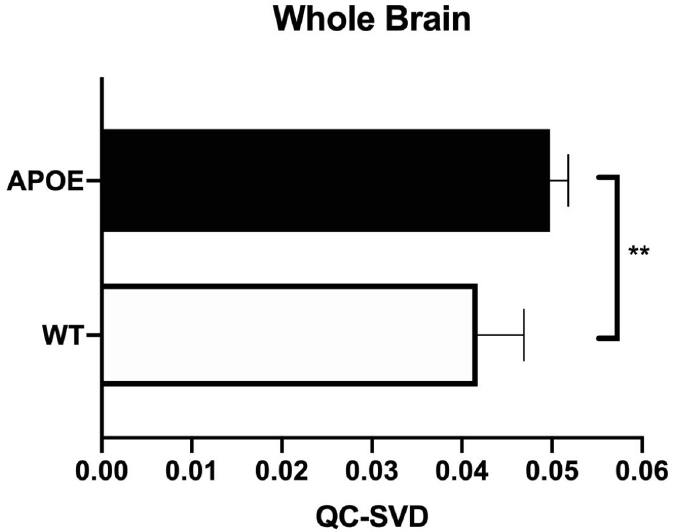
Fig 5. Average whole brain QC-SVD. All of the voxels in the entire rat brain were sampled as one single region-of- interest to calculate the QC-SVD of the whole brain of each animal and compared between genotypes. An independent t-test (p = 0.002) was utilized for this additional comparison. This illustration includes the average QC-SVD (p = 0.003) and SD between genotypes. Group sample sizes at 8 months were (WT, n = 5; APOE4, n = 6).